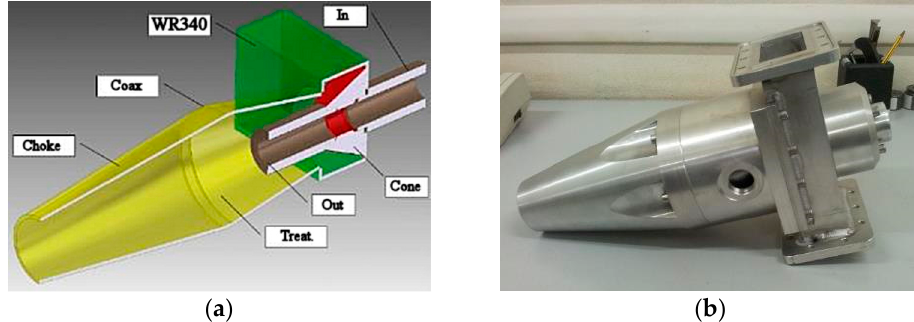
Figure 1. Microwave plasma torch: ( a ) cross-sectional view of the torch with the components labelled, and ( b ) picture of the aluminum torch, including the cooling section. Image: courtesy of Metallurgica Abruzzese SpA, Italy.